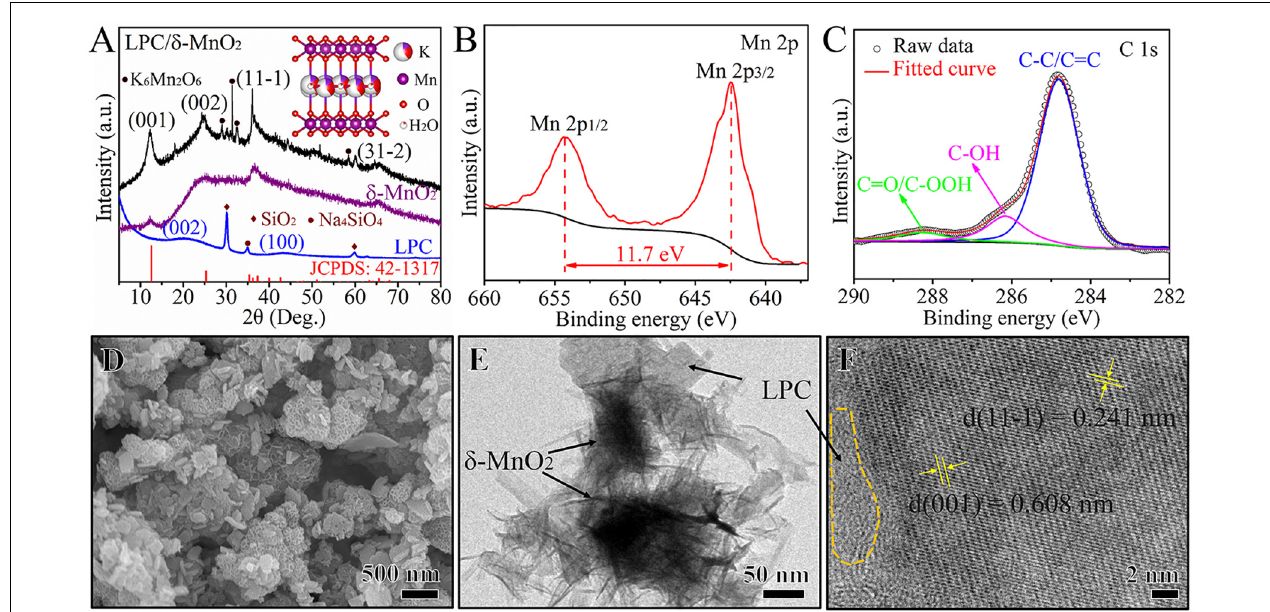
FIGURE 1 | (A) XRD patterns of LPC, δ -MnO 2 , and LPC/ δ -MnO 2 nanocomposite (the insert shows crystal structure of δ -MnO 2 ). (B) High-resolution Mn 2p, and (C) C 1s XPS spectra of LPC/ δ -MnO 2 . (D) SEM image, and (E,F) TEM images of LPC/ δ -MnO 2 .